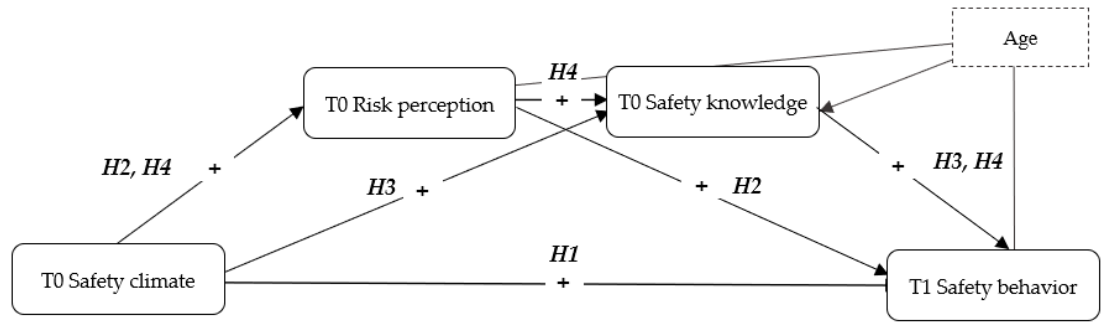
Figure 1. The hypothesized serial mediation model.